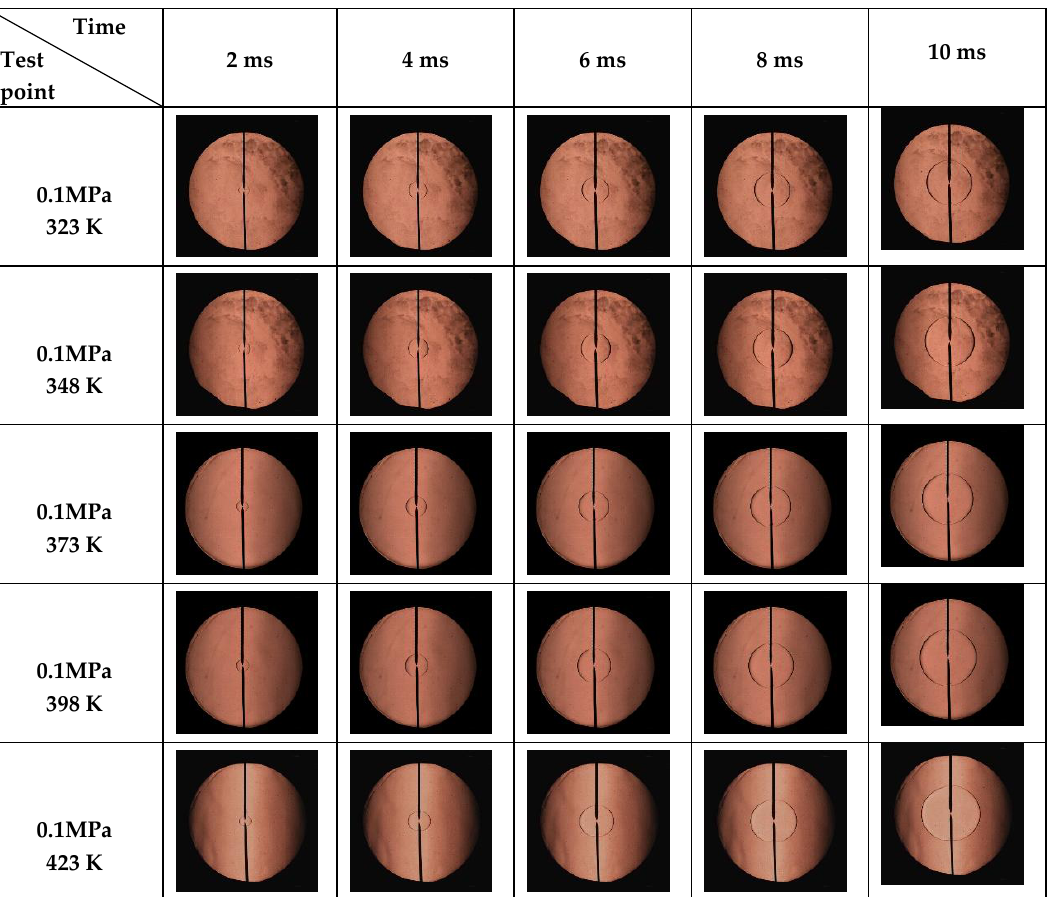
Figure A1. Schlieren photographs of flame propagation under different initial temperatures ( DR = 2%, Φ = 1.0).